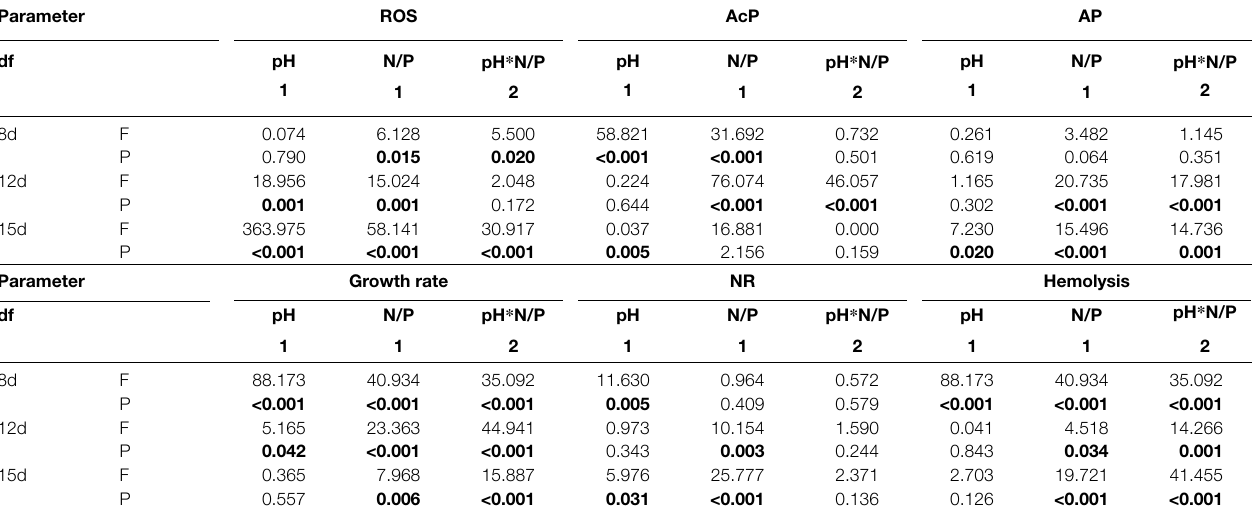
TABLE 3 | Two-way ANOVA summary on combined effects of seawater acidification (pH) and nutrient status (N/P) on ROS level, AcP activities, AP activities, growth rate, NR activities, and Hemolysis rate of K. mikimotoi at pH 8.1, 7.6, and 7.4; N/P: 7:1, 17:1 and 52:1. Parameter ROS AcP